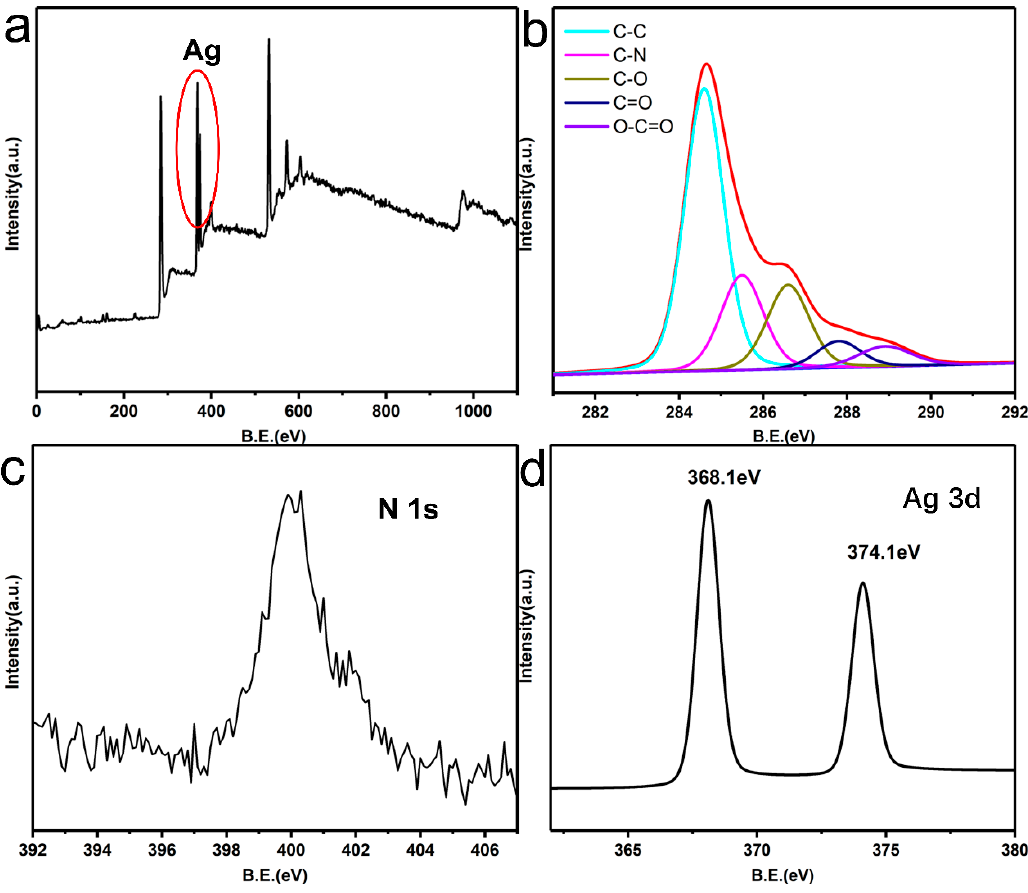
Figure 4. XPS survey scans of Ag-PDA-RGO ( a ), C 1s XPS spectra of Ag-PDA-RGO ( b ), N 1s XPS spectra of Ag-PDA-RGO ( c ), and Ag 3d core-level spectrum of Ag-PDA-RGO ( d ).